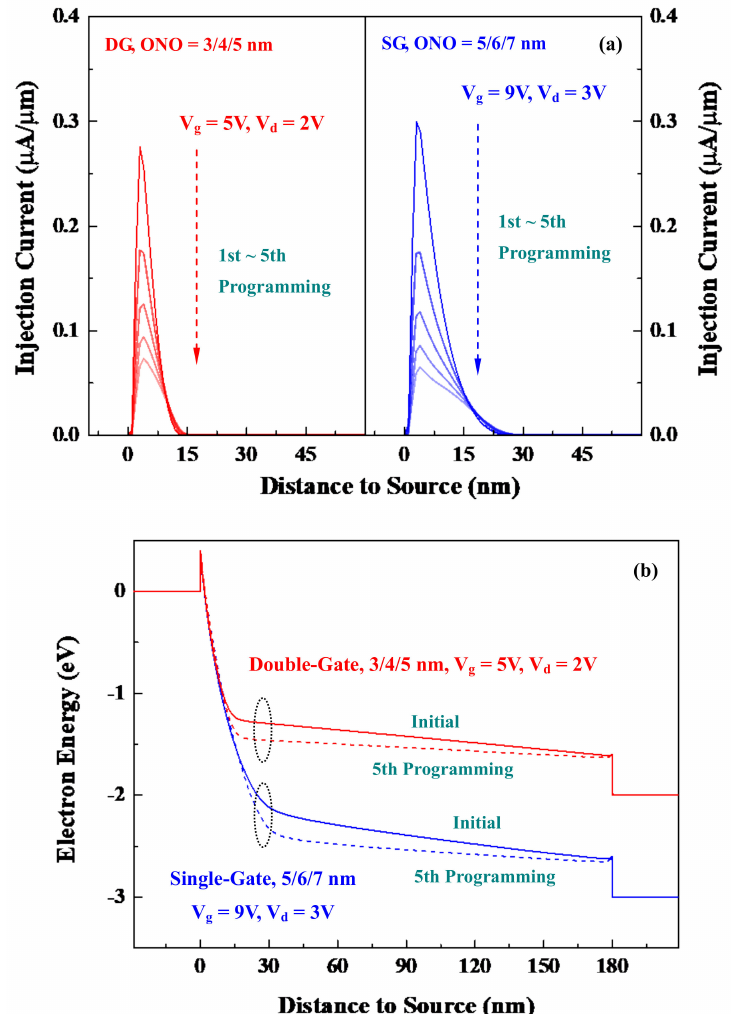
Figure 12. ( a ) Iterative results of spatial distributions of injection currents in scaled double-gate and non-scaled single-gate Schottky barrier cells; ( b ) associated conduction band diagrams of Schottky barrier cells along the channel surface at the initial and the 5th programming